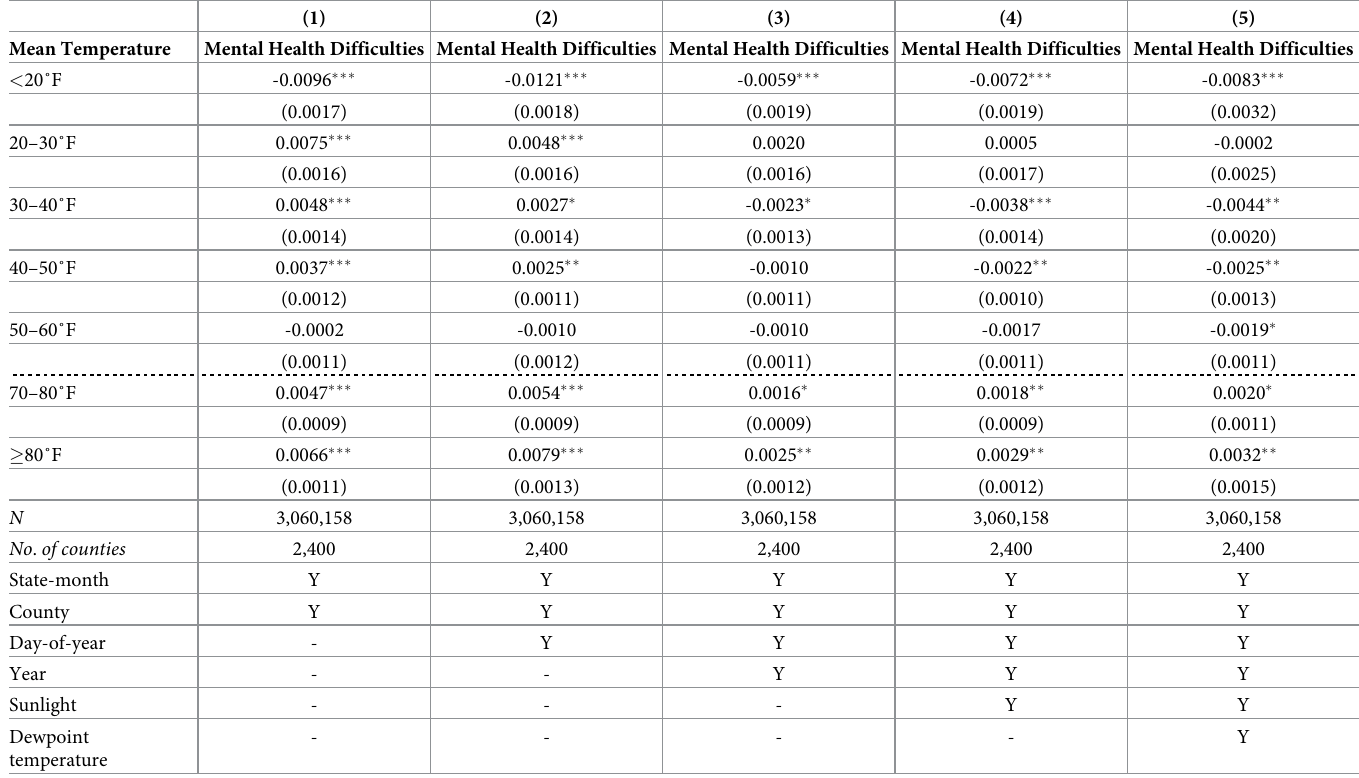
Table 2. Effect of temperature over the previous 30 days on the probability of self-reported mental health difficulties.